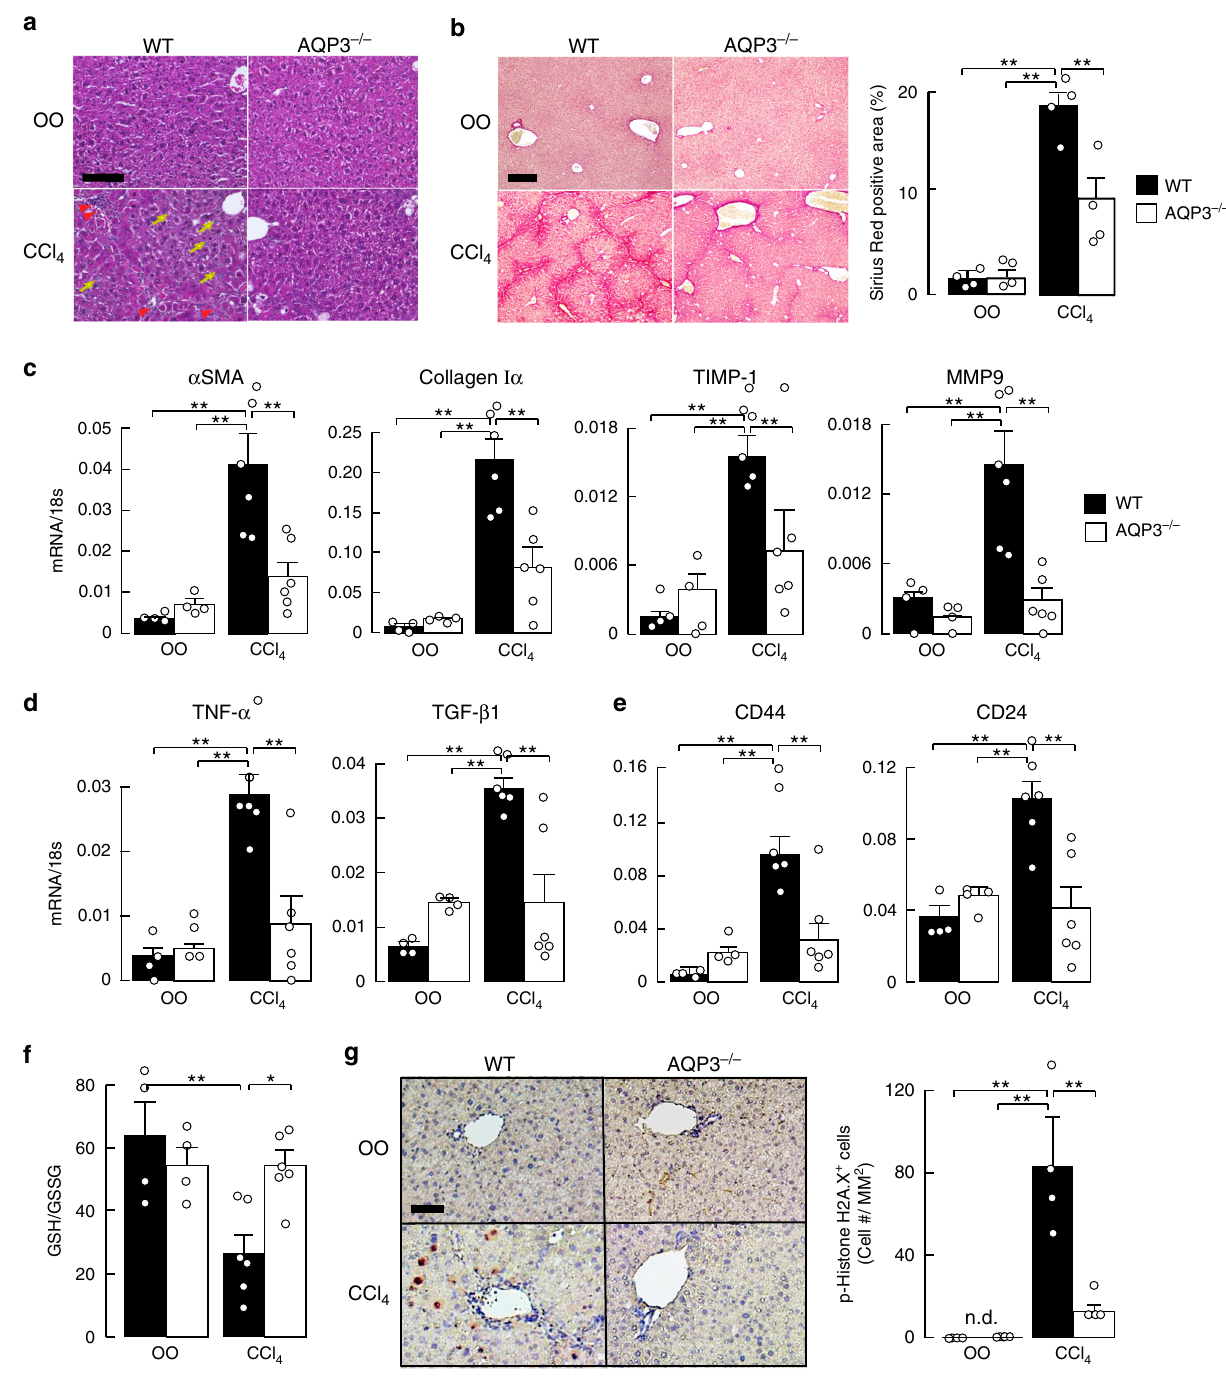
Fig. 4 Reduced CCl 4 -induced chronic liver injury in AQP3 − / − mice. a – g CCl 4 (0.5 ml/kg) or vehicle olive oil (OO) was intraperitoneally injected twice a week for 6 weeks. a Hematoxylin and eosin staining of liver from WT and AQP3 − / − mice. Bar, 100 µ m. Arrow: in fi ltrating lymphocytes. b (left) Sirius red staining. Bar, 200 µ m. (right) Sirius red-positive staining area (mean± SE, n = 4 sections from 4 individual mice, ** p < 0.01). c – e mRNA expression of indicated genes in liver homogenates by real-time RT-PCR (mean ± SE, n = 4 for olive oil, n = 6 for CCl 4 mice/group, ** p < 0.01). Data are expressed as the ratio to 18s RNA. f Ratio of GSH to GSSG in liver homogenate (mean ± SE, n = 4 for olive oil, n = 6 for CCl 4 mice/group * p < 0.05, ** p < 0.01). g (left) Phospho-histone H2A.X staining. Bar, 200 µ m. (right) Number of phospho-histone H2A.X-positive stained cells (mean ± SE, n = 4 sections from